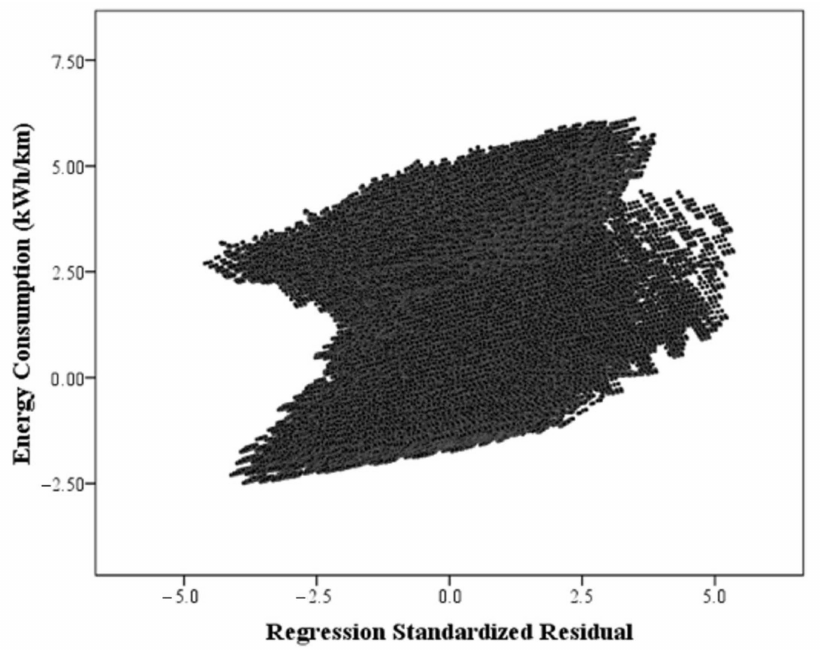
Figure A3. A scatter plot for the regression standardized residuals (n =